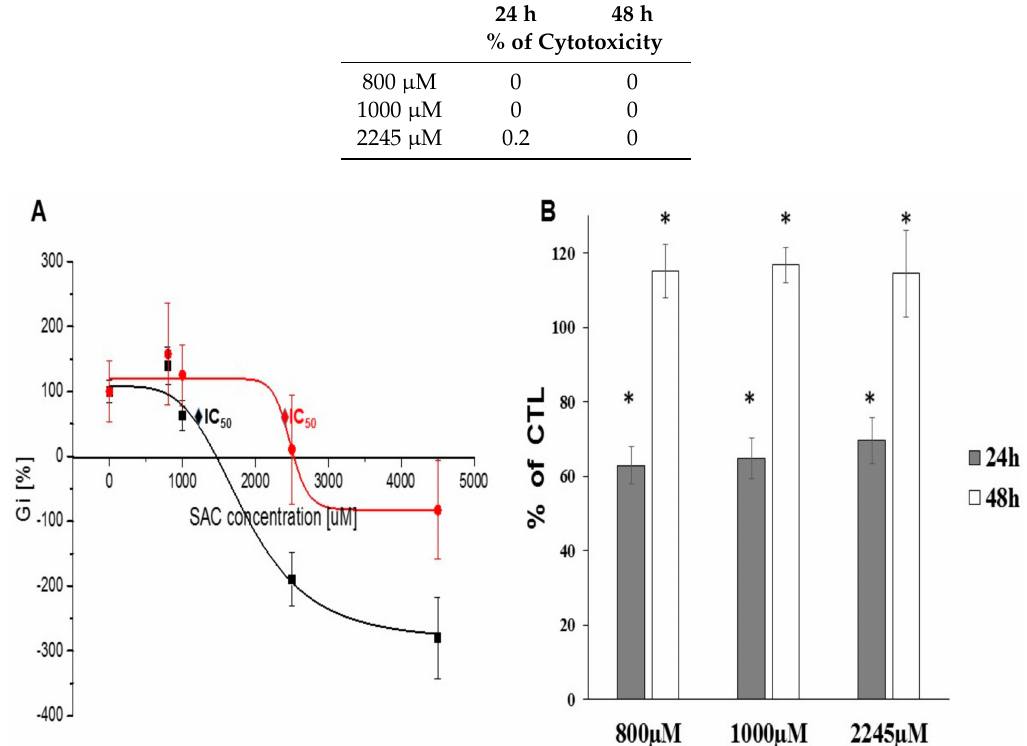
Figure 1. The cell viability after the 24 h and 48 h incubations with 800 µ M, 1000 µ M and 2245 µ M SAC in the MCF-7 cell culture ( A ) generated by OriginPro 9.1 program, ( B ) the MTT assay; Gi: growth inhibition, IC 50 : half maximal inhibitory concentration. The sigmoidal model of e ff ect dependence on SAC dose was adjusted to the obtained data according to the method described in Lasota et al. [19]. All the data of the mean value represent the average of four to five determinations in three experimental groups. Statistical analysis was performed using the Mann–Whitney test (* p < 0.05), * p < 0.05 vs. the